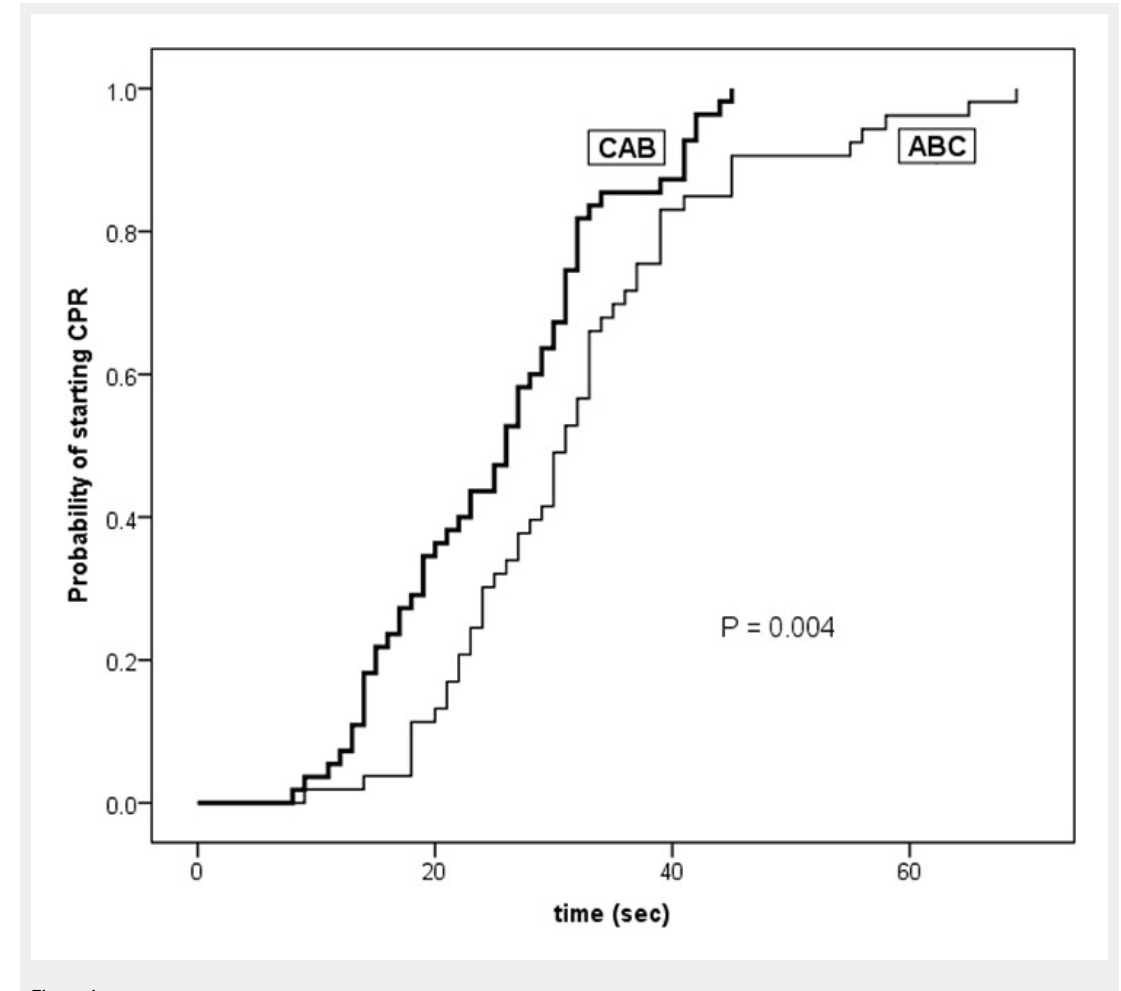
Figure 4 Kaplan-Meier diagram displaying the probability of executing a first initial measure of CPR over time. Teams were randomized to apply either ABC or CAB as initial approach to CPR. Time 0 is defined as first touch of the patient by one of the rescuers. Curves differ significantly (log-rank